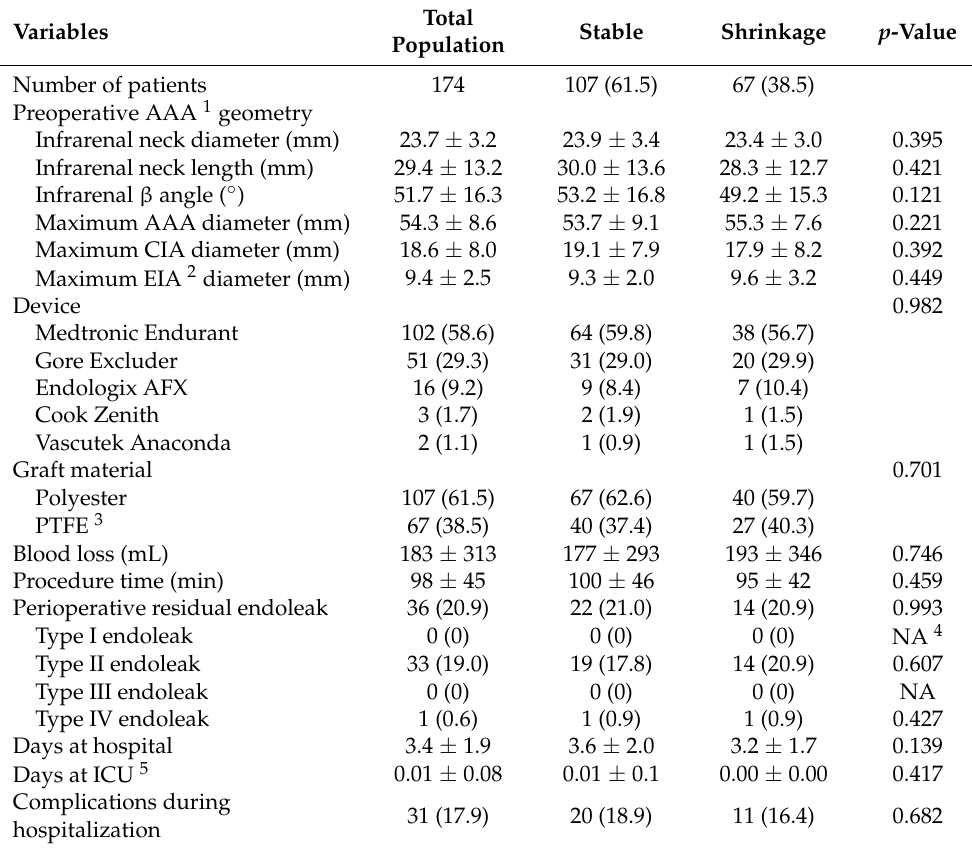
Table 2. Baseline AAA- and EVAR-related characteristics of the study population stratified by AAA